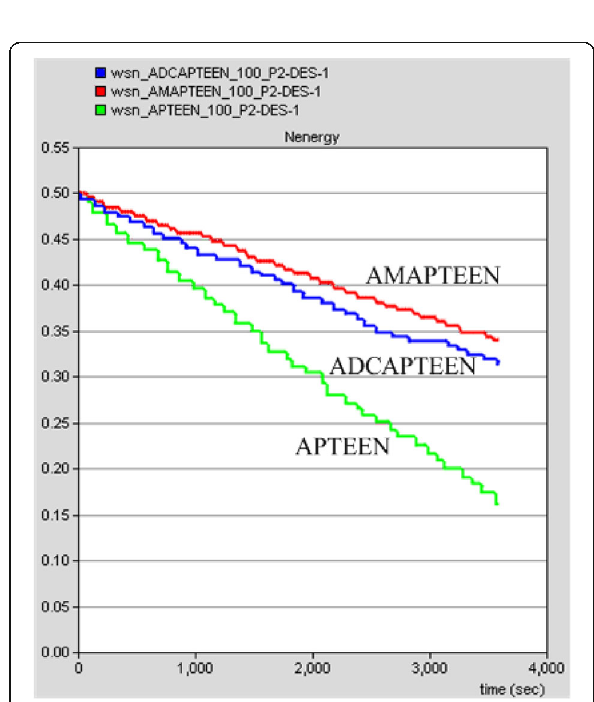
Fig. 16 Energy consumption between ADCAPTEEN and AMAPTEEN. The energy consumption of a single node compared with ADCAPTEEN and AMAPTEEN is shown in this figure, The results show the energy consumption of AMAPTEEN routing algorithm is smaller than